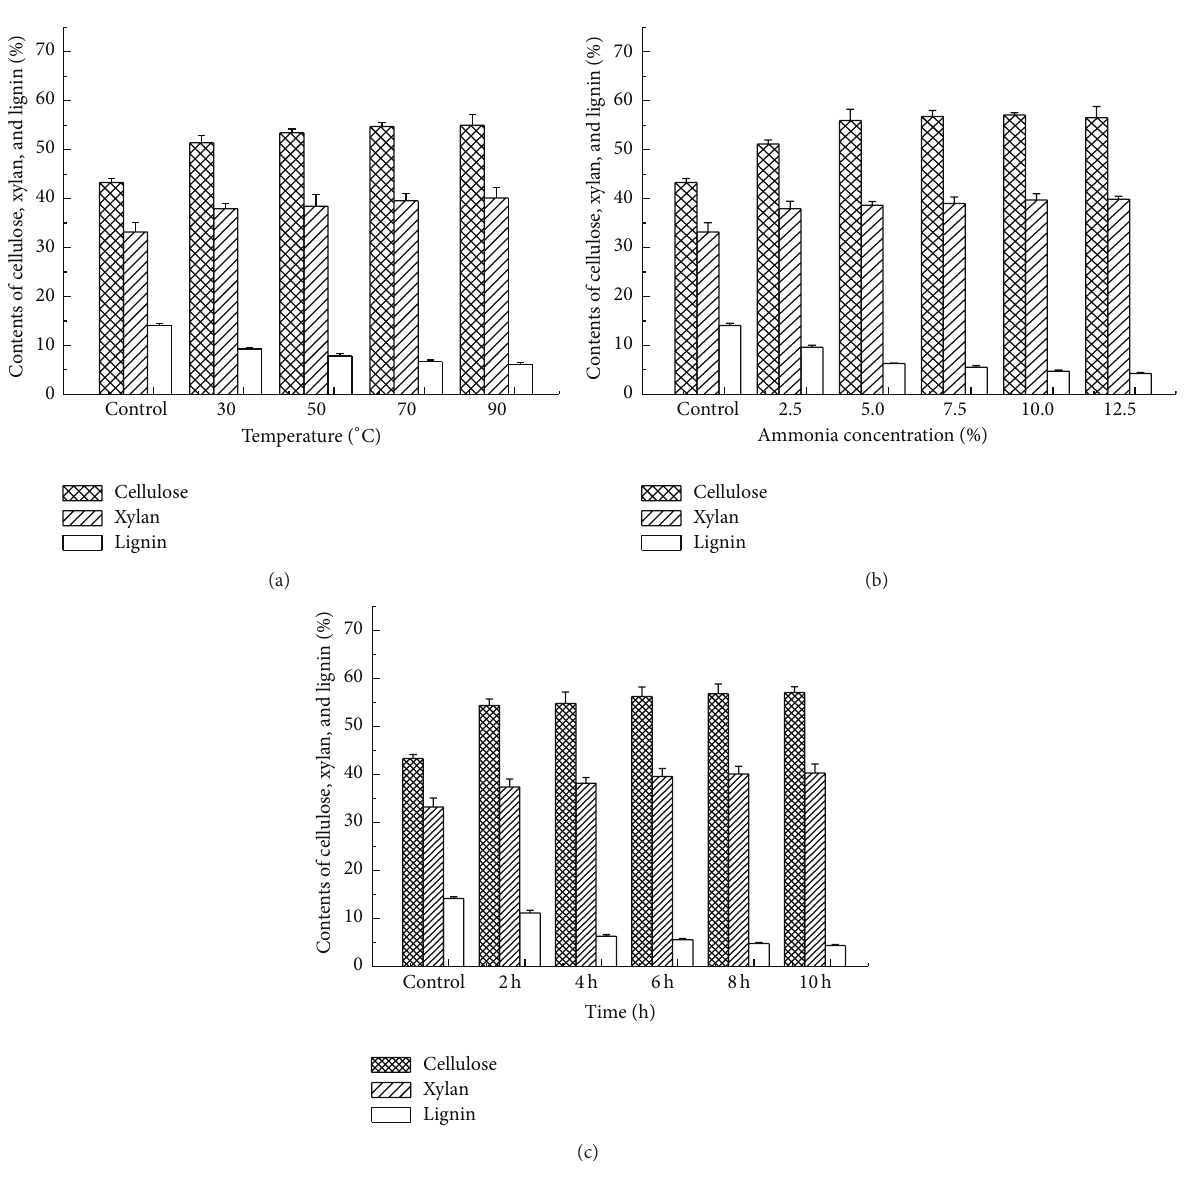
Figure 1: Chemical compositions of corncob with and without SAA pretreatment ((a) the ammonia concentration in aqueous solution 5%, time 6 h; (b) temperature 90 ∘ C, time 6 h; (c) temperature 70 ∘ C, the ammonia concentration in aqueous solution